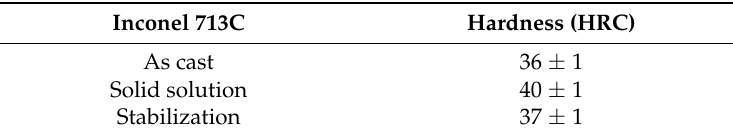
Table 2. Results of the Rockwell C hardness tests in the